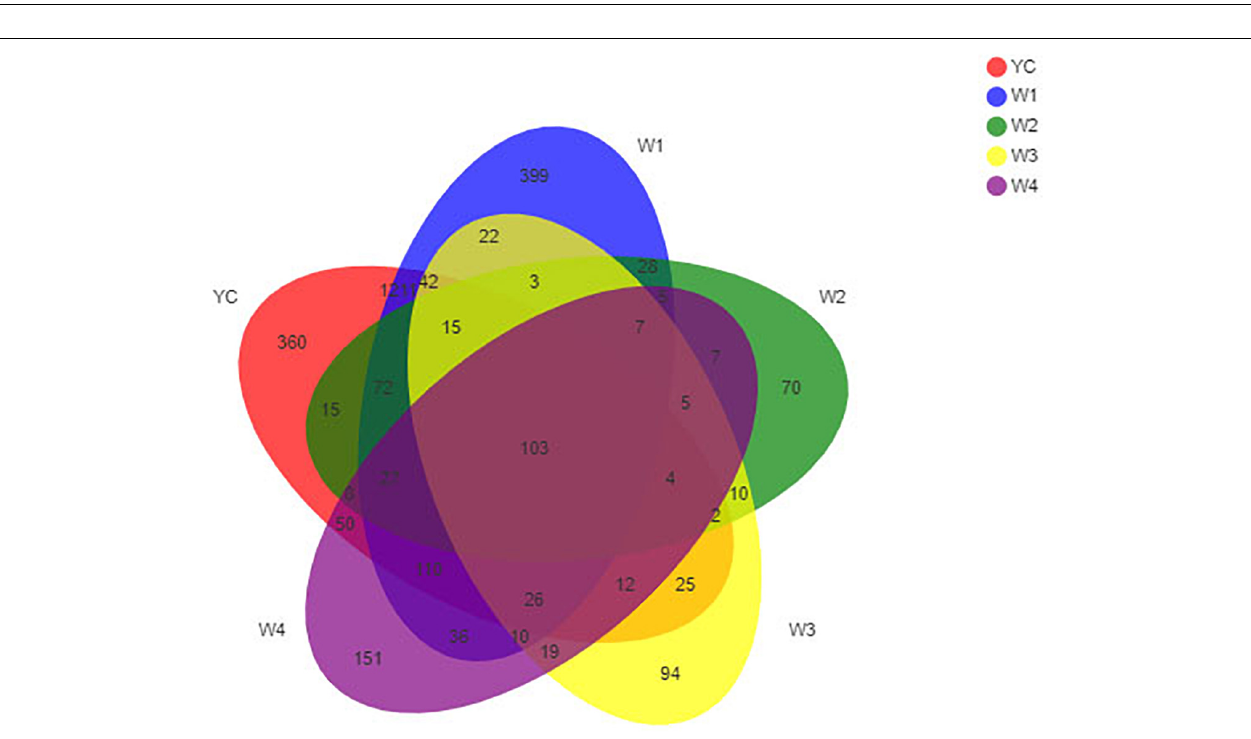
FIGURE 2 | OTU Venn analysis. Different groups are represented by different colors, and numbers in overlapping portions represent the number of species common among all groups.